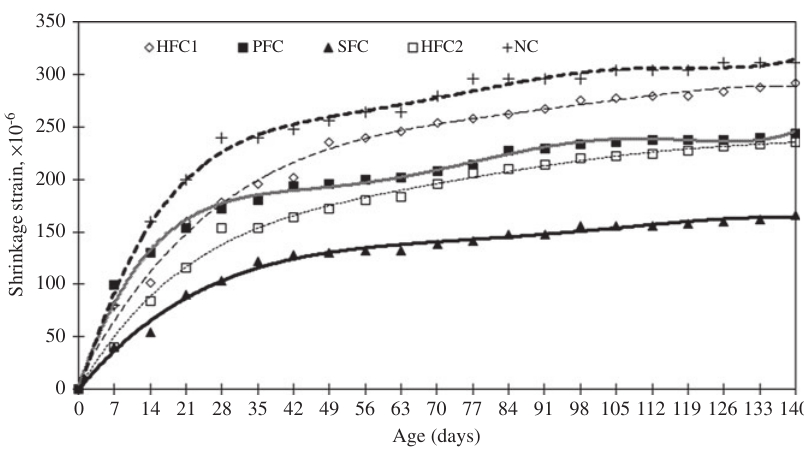
Figure 8 Drying shrinkage of concrete series up to the age of 140 days.